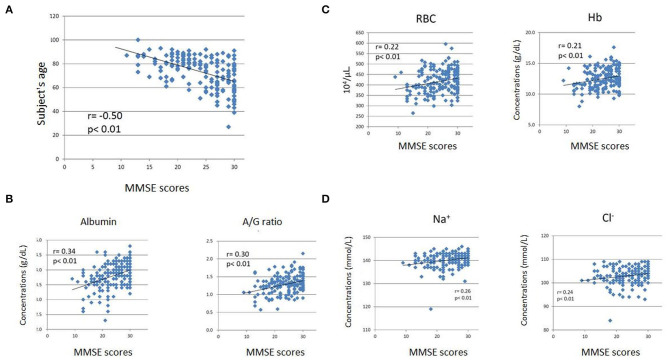
Scatter plots of Mini-Mental State Examination (MMSE) scores and subjects' ages (A), albumin level and A/G ratio (B), RBC count and Hb level (C), and sodium (Na) and chloride (Cl) levels (D). The subjects' age exhibited a significant negative correlation with MMSE scores (A). The blood test items exhibited weak but significant positive correlations with MMSE scores (B–D). The horizontal axes indicate MMSE scores, while the vertical axes indicate age (A) and concentrations (B-albumin, C,D).